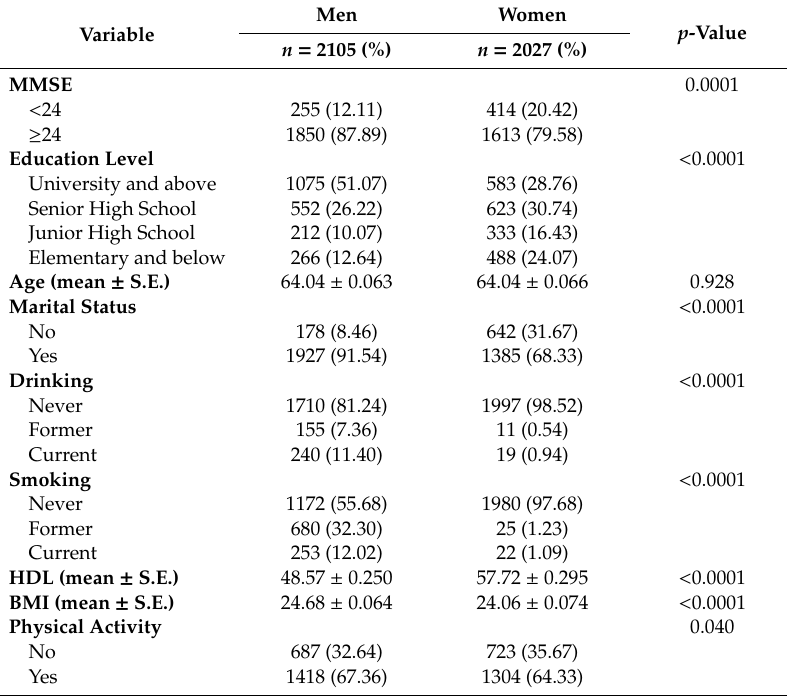
Table 1. Demographic characteristics of study participants.